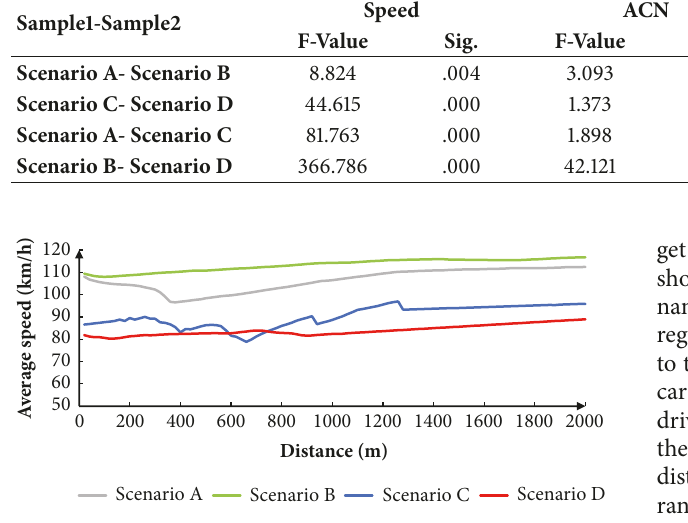
Figure 8: Distribution of average speed under different scenarios.